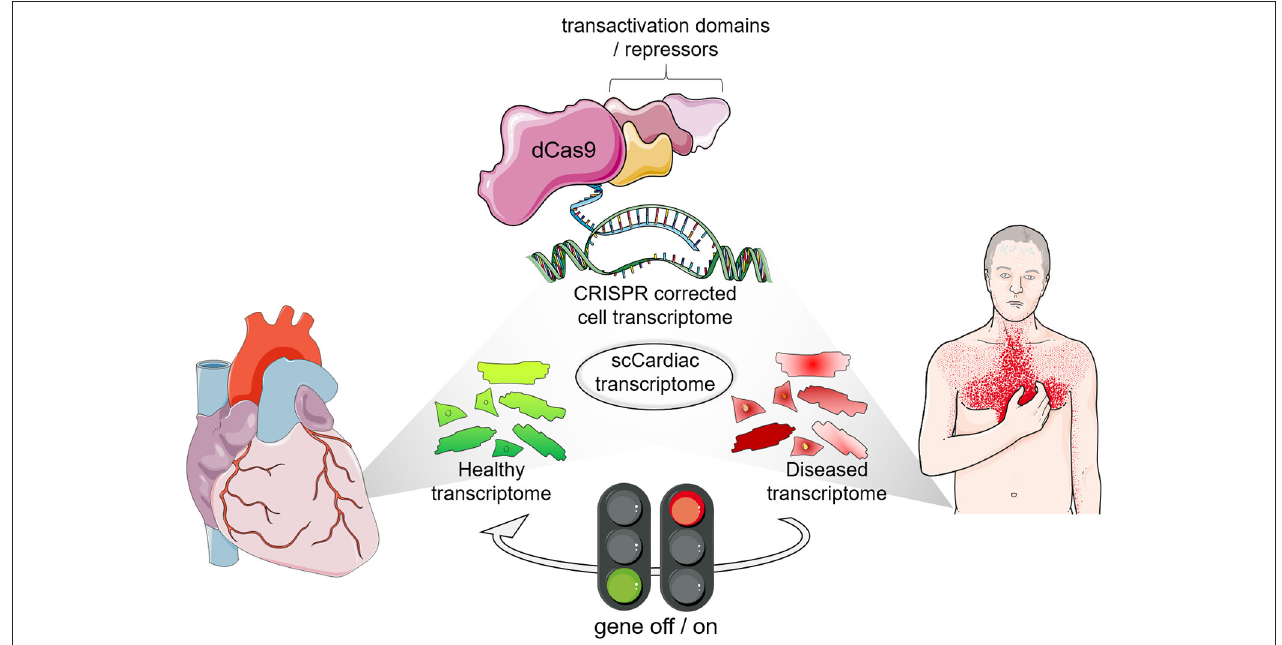
FIGURE 1 | The era of transcription profile analyses and transcriptional engineering at single cell resolution. Single cell (SC) transcriptomics identified cell types in healthy and diseased cardiomyocytes along with their transcriptional profile. Interference with gene expression is possible with CRISPR-based synthetic transcription factors to steer gene expression profiles of specific subpopulations of target cells in the